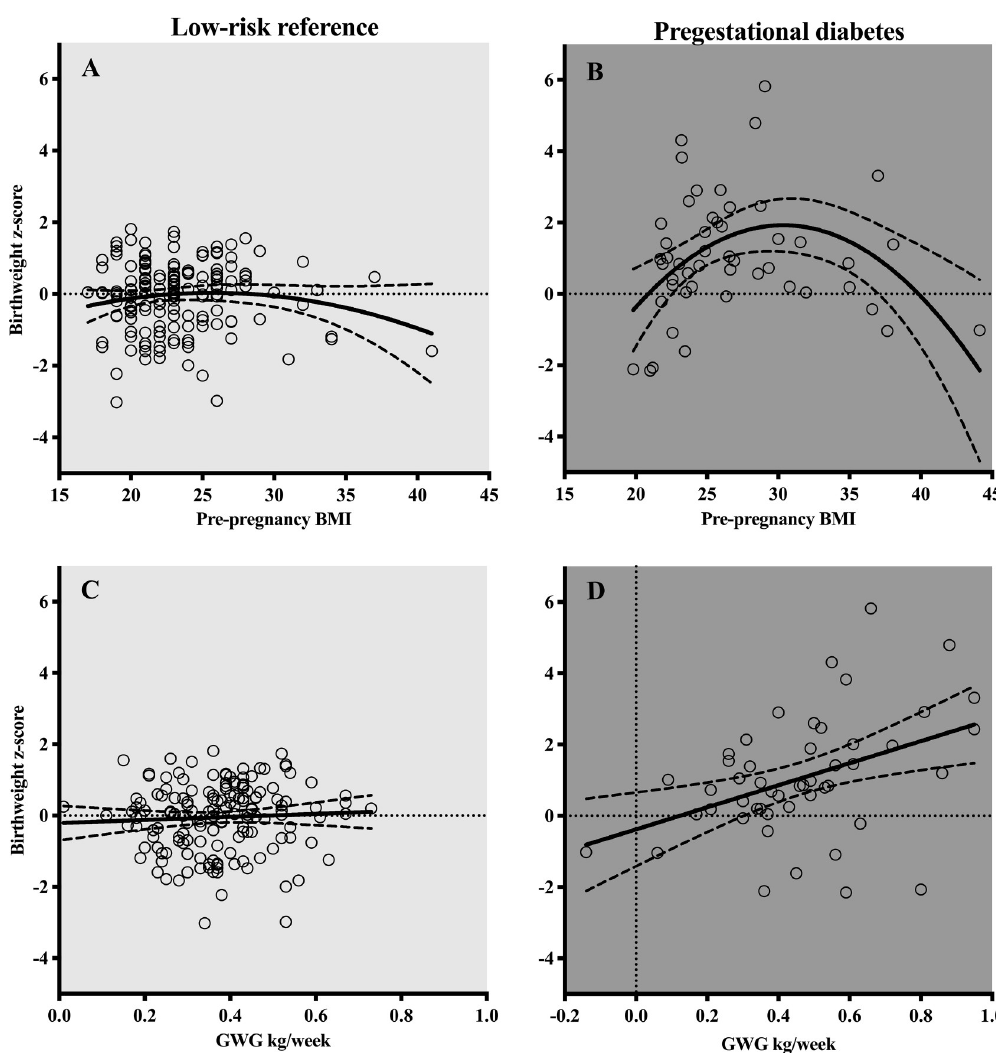
Fig 3. Relation between body mass index and gestational weight gain and birthweight z-score in the reference and pregestational diabetes populations (160 and 49 participants, respectively).